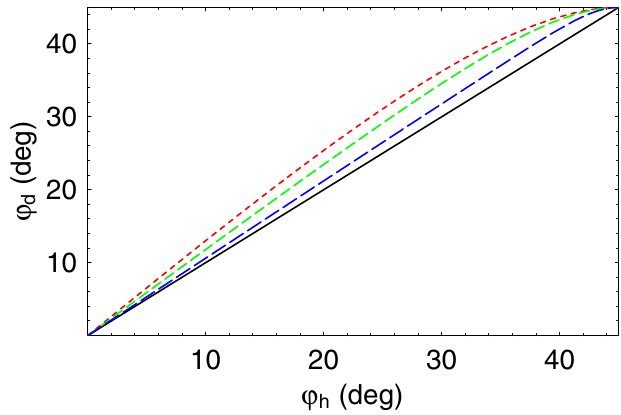
FIG. 3. (Color) Direction ’ of the transverse impedance (40) d versus hole position on the side wall of a square chamber for !b= (cid:2) (cid:5)(cid:2)(cid:7)c (cid:3) (cid:5) 0 ; 3 ; 10 (short-dashed, dashed, and long-dashed curves). The solid line is for a circular pipe.